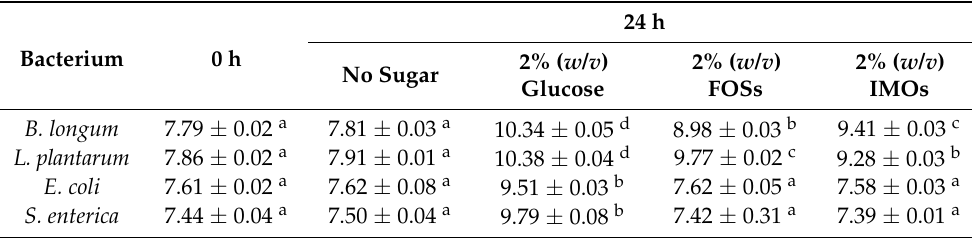
Table 2. Growth of probiotic and pathogenic bacteria in the medium without a carbon source and with glucose, FOSs and IMOs (number of cells reported as log 10